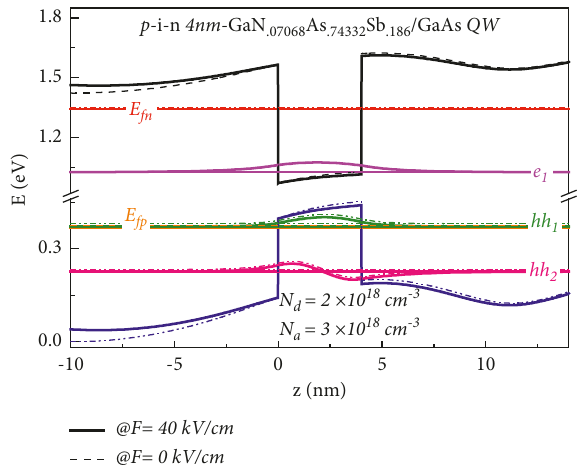
0.070 As 0.743 Sb 0.186 /n-